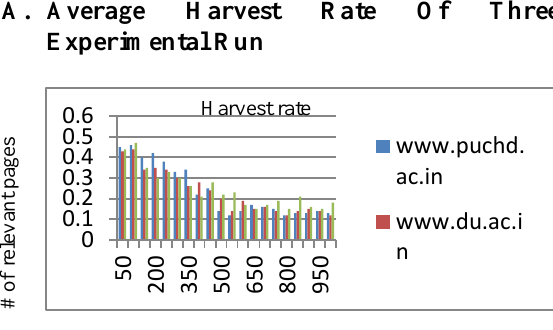
Figure 3. Graph for Harvest Ratio Of